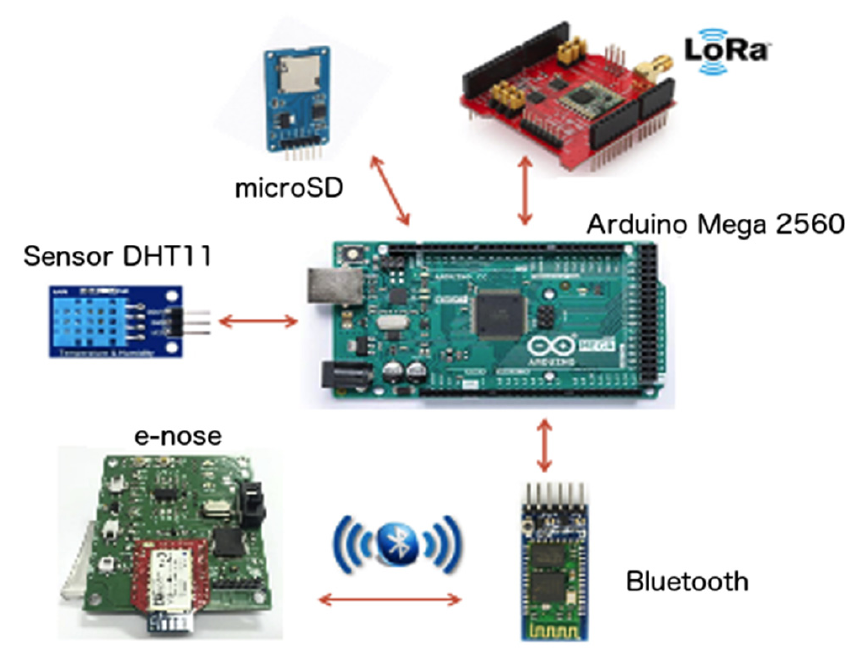
Figure 2. Beacon Figure 2. Beacon components. Figure 2. Beacon components.